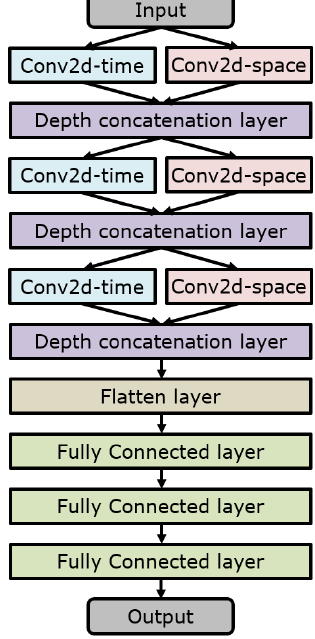
Figure 5. Structure of 2D CNN accepting previous traffic